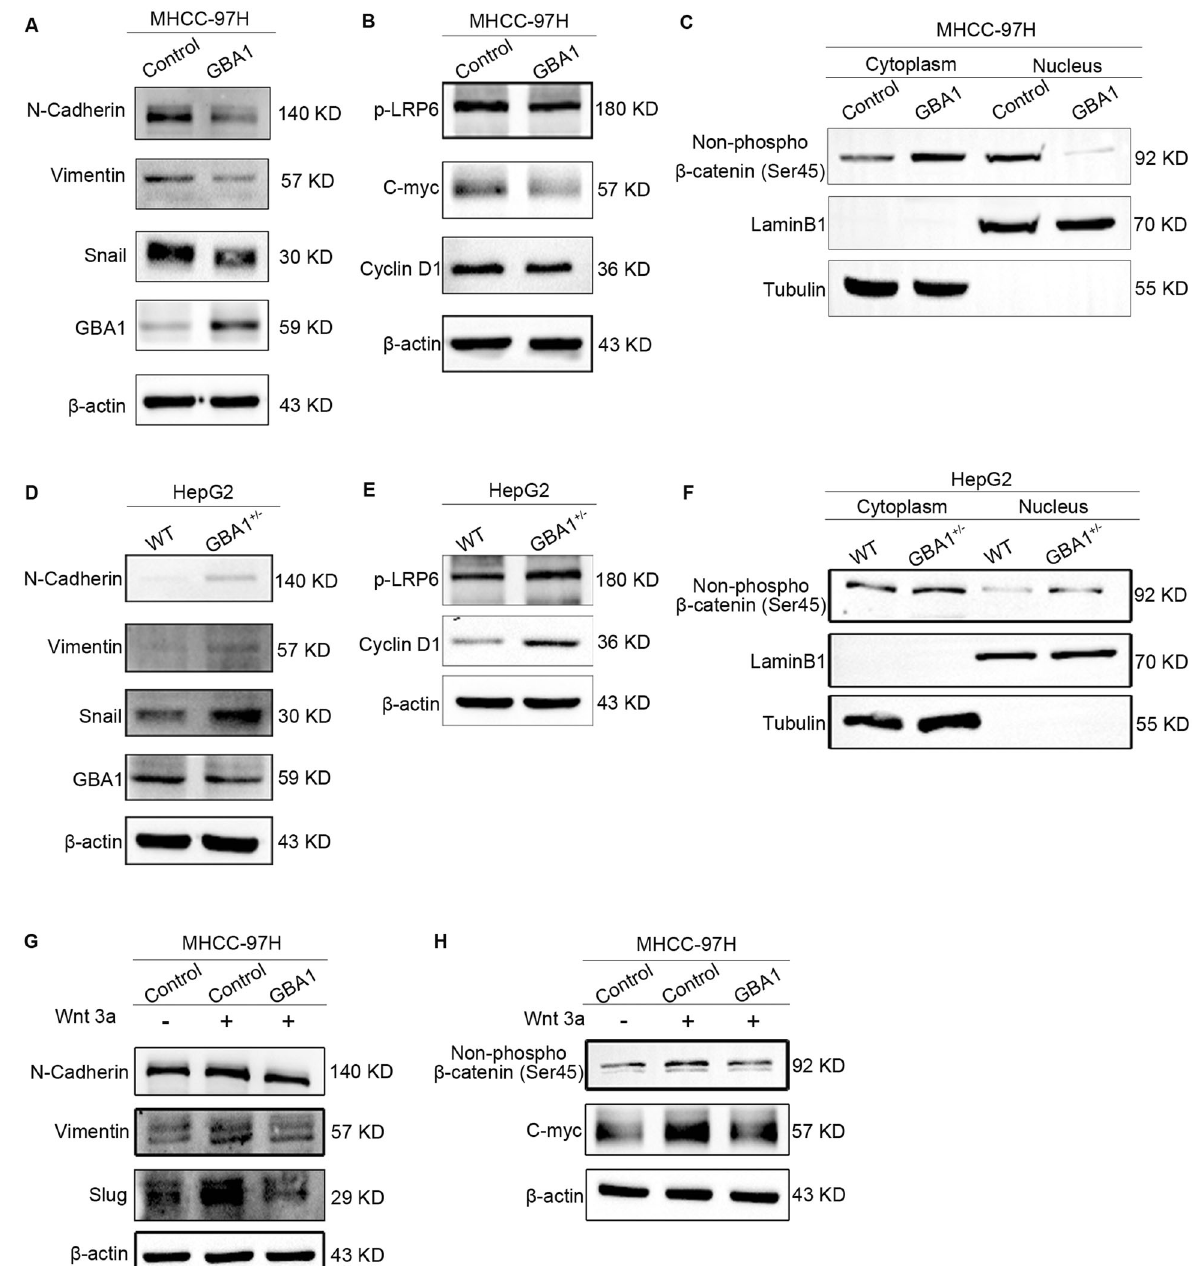
Fig. 3 Low expression of GBA1 promotes the epithelial-mesenchymal transition (EMT) via activation of the Wnt/ β -catenin signalling pathway. A , D The expression of EMT markers in MHCC-97H cells with stable GBA1 overexpression ( A ) or HepG2 cells with stable GBA1 downregulation ( D ) as detected by Western blotting. B , E The expression of phospho-LRP6 and the Wnt target genes c-myc and/or cyclin D1, which are related to the Wnt signalling pathway in MHCC-97H cells with stable GBA1 overexpression ( B ) or HepG2 cells with stable GBA1 downregulation ( E ) was detected by Western blotting. C , F Western blot analysis was performed to determine the level of non-phospho- β -catenin in the cytoplasm and nucleus of MHCC-97H cells with stable GBA1 overexpression ( C ) or HepG2 cells with stable GBA1 downregulation ( F ). G Western blotting was performed to analyse the effect of GBA1 overexpression on the Wnt3a-activating EMT. H Western blotting was performed to analyse the effect of GBA1 overexpression on the Wnt3a-activated Wnt signalling pathway.